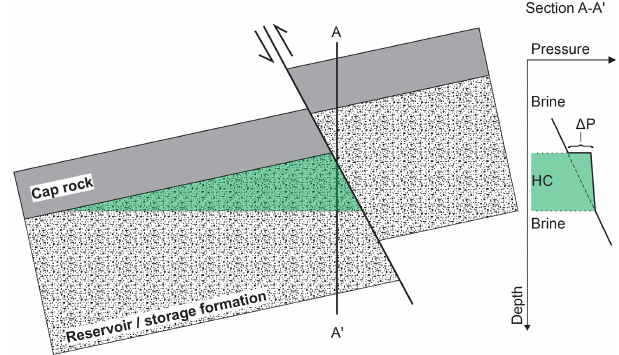
Figure 2. Injection of CO 2 into a faulted geological formation where the fault is sealing. The buoyancy of CO 2 creates a pressure difference at the seal and fault displayed on a pressure–depth plot for the point of the diagram labelled